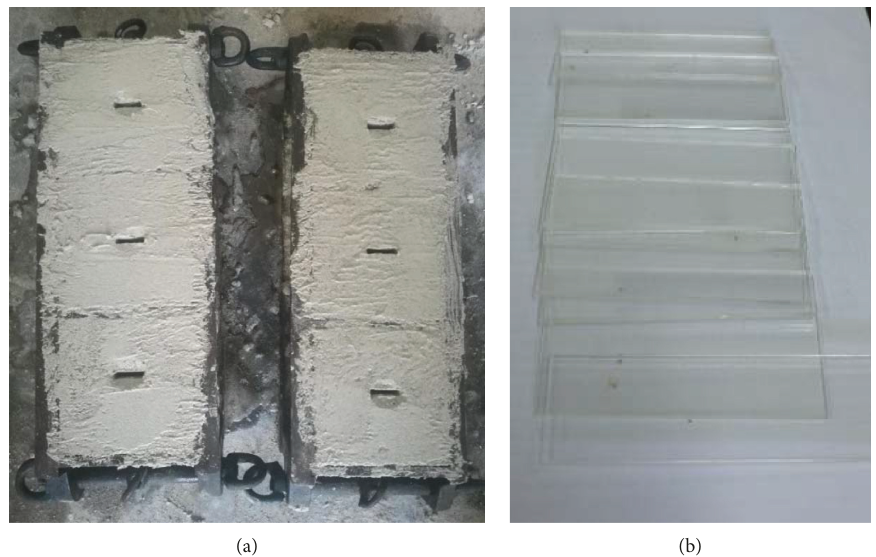
Figure 1: Specimen and test equipment. (a) Specimen diagram and (b) acrylic sheet.